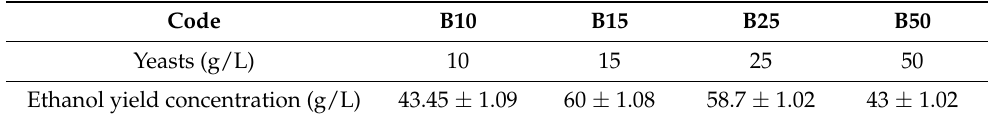
Table 2. Influence of yeast concentration on bioethanol